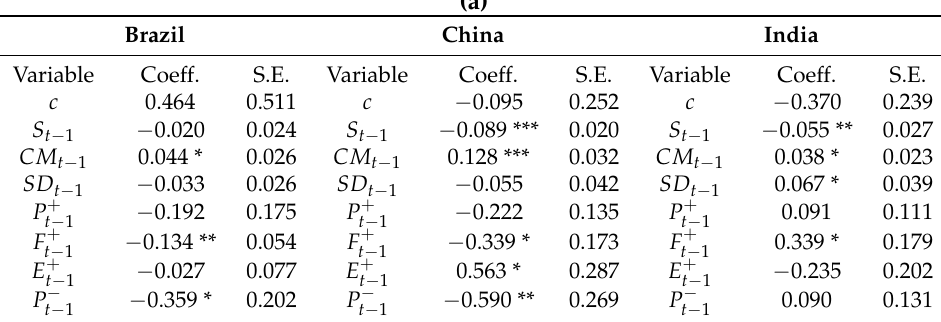
Table 2. Nonlinear ARDL estimation results for stock market